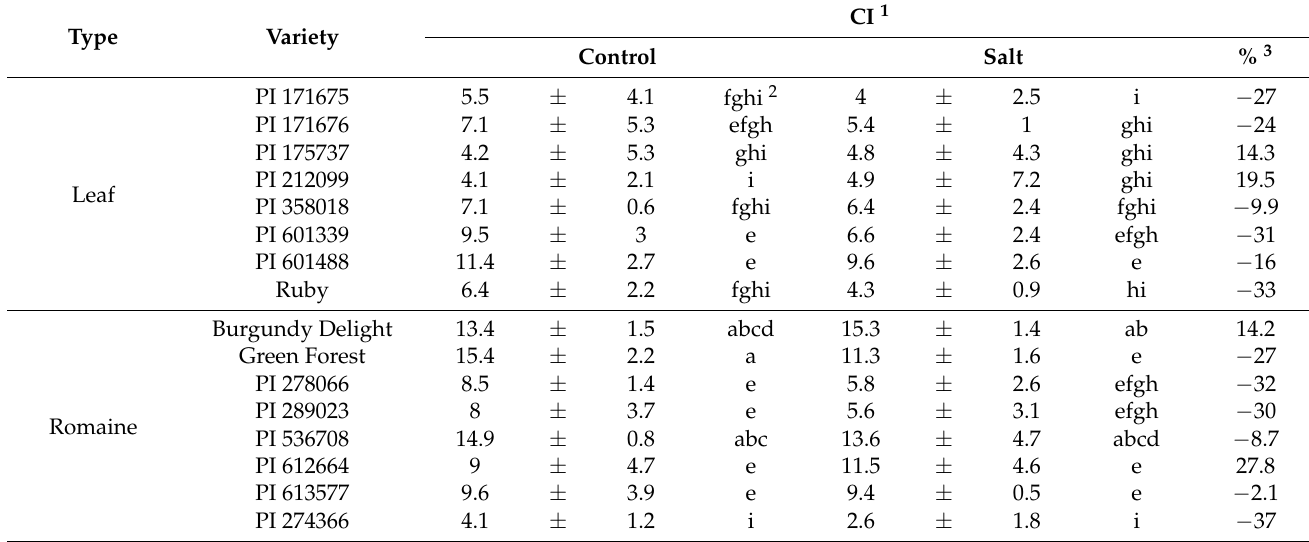
Table 8. Chlorophyll index (CI) (mean ± standard deviation, n = 6) of leaf- and romaine-type lettuce cultivars grown under control and salt-stress conditions (100 mM) after 42 days of sowing (10 days after salt